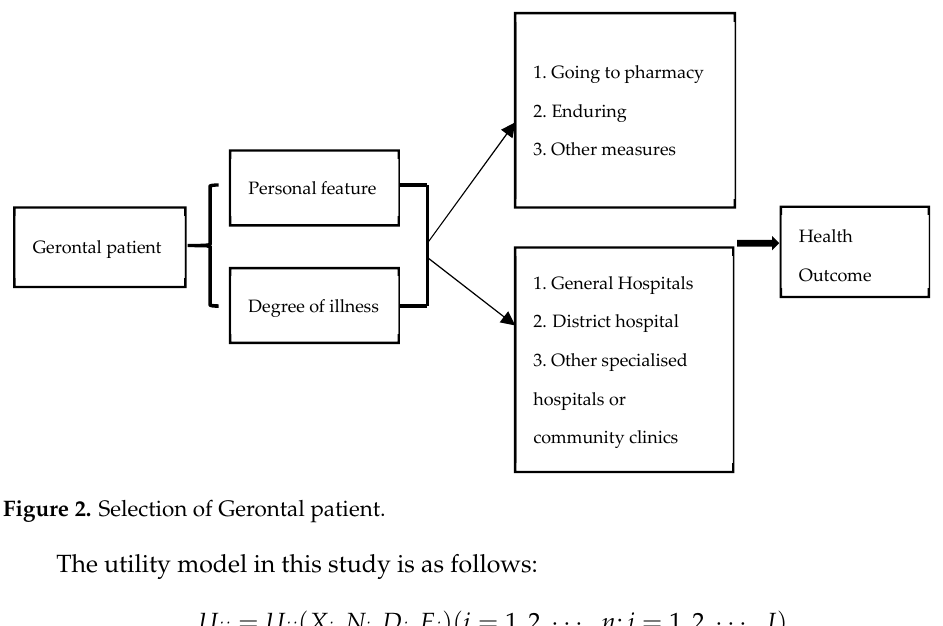
Figure 2. Selection of Gerontal patient.